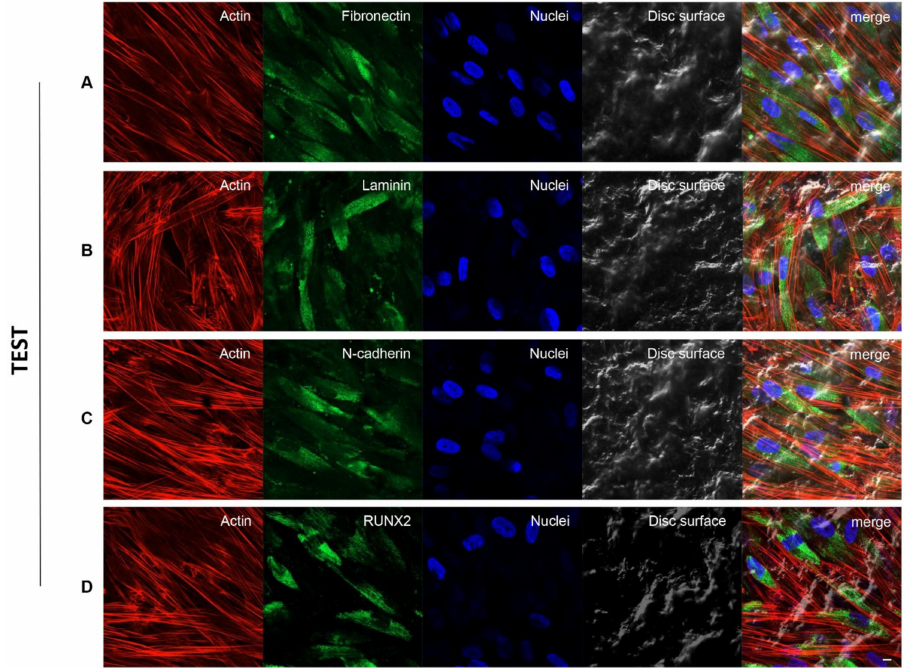
Figure 5. Human PDLSCs cultured on TEST titanium implant surface were observed after 8 weeks of incubation. Cytoskeleton actin was stained in red fluorescence; specific markers ( A ) Fibronectin. This picture was taken from the paper published [14]. ( B ) Laminin, ( C ) N-cadherin and ( D ) RUNX2, were stained in green fluorescence; nuclei were stained in blue fluorescence. Scale bar: 10 µ